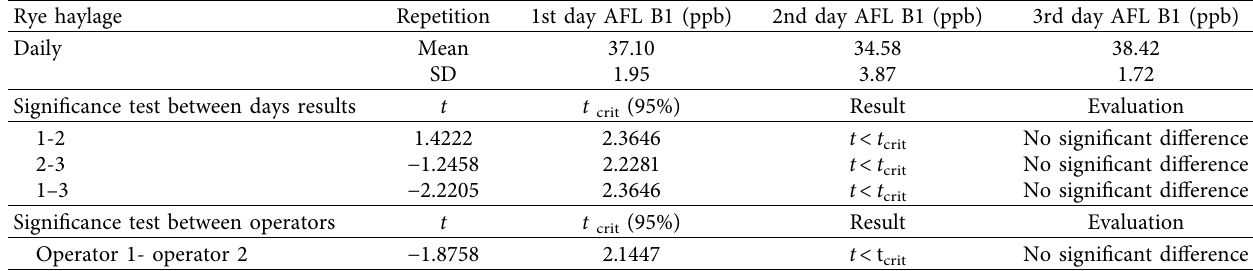
Table 5: Repeatability of the ELISA method for rye haylage. Two operators measured AFL B1 in three repetitions on three different days from freshly prepared samples. SD, standard deviation. Spike: 40ppb AFL B1.